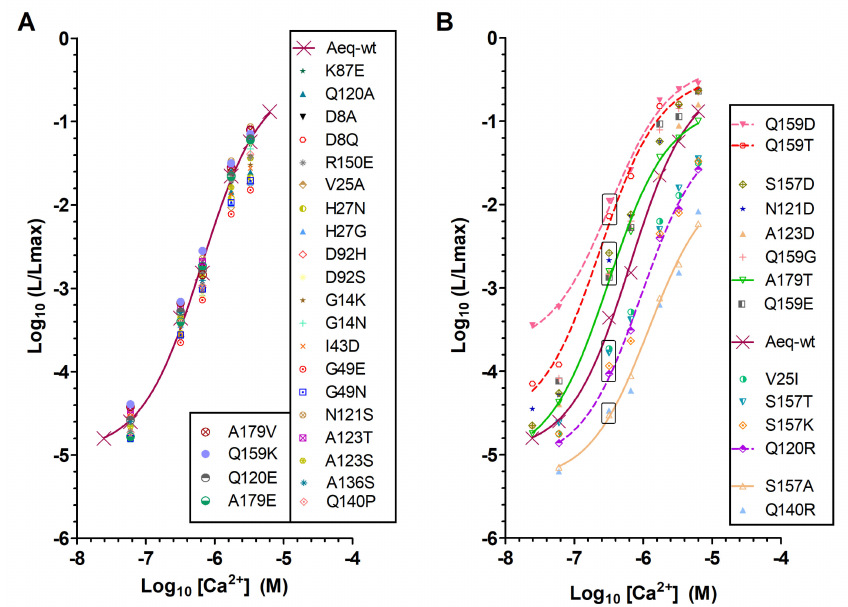
Figure 2. Ca 2 + sensitivity of aequorin mutants. The relationship between Ca 2 + concentration ([Ca 2 + ]) and fractional bioluminescence intensity (L / Lmax) is displayed in Log values on a linear scale. L